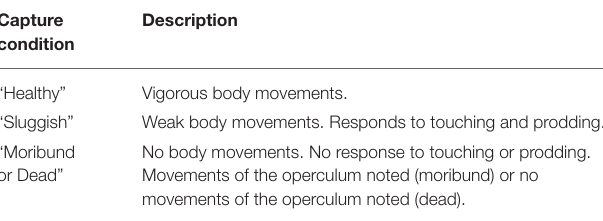
TABLE 1 | Capture condition descriptions adapted from Benoît et al. (2010). Capture condition